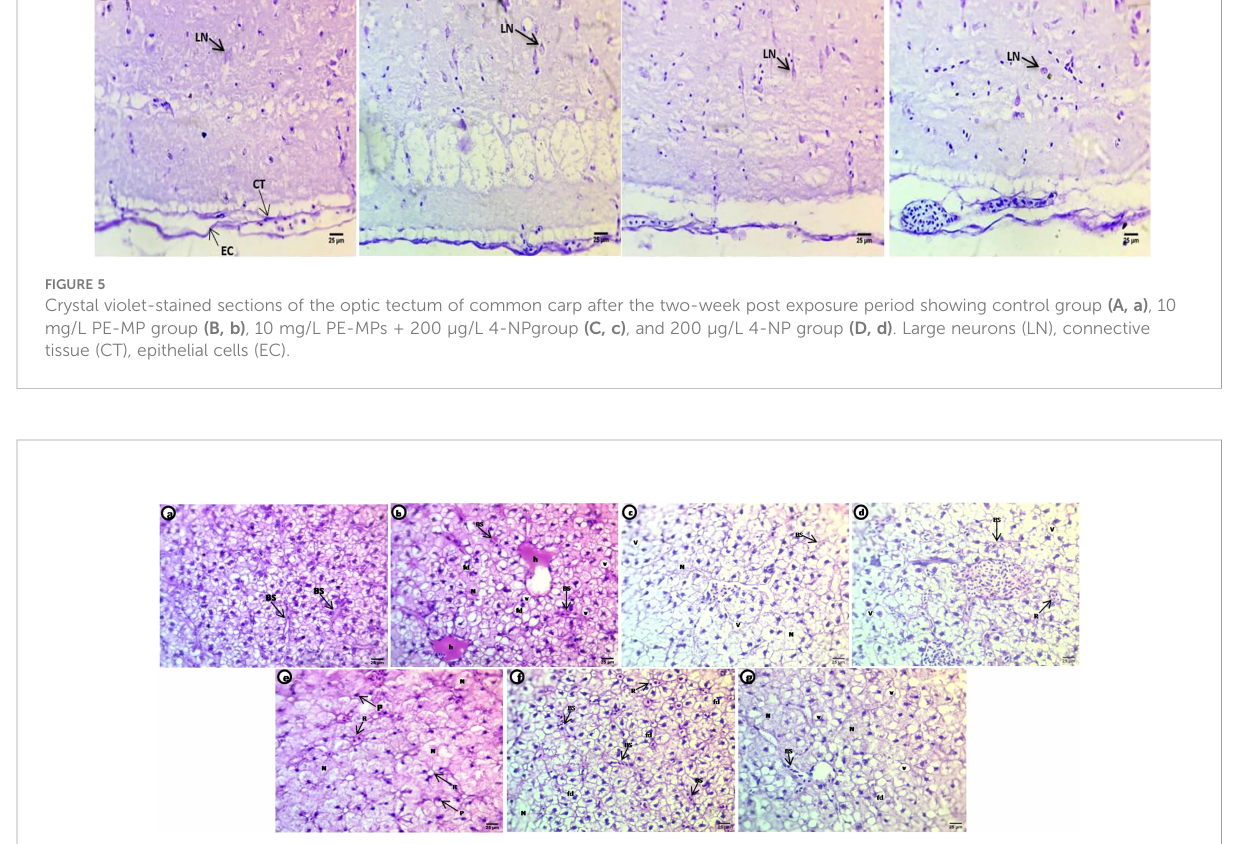
FIGURE 6 H&E-stained sections of liver of common carp showing the normal morphology of hepatocytes of the control group (A) and selective deformations in shape after treatment with 10 mg/L PE-MPs, 10 mg/L PE-MPs +200 µg/L 4-NP, and 200 µg/L 4-NP, as (B – D) for exposure period and (E – G) for post exposure period, respectively. Blood sinusoids (BS), pyknotic nuclei (P), fatty degeneration (fd), hemorrhage (h), necrotic area (N), rosette shape (R), vacuoles